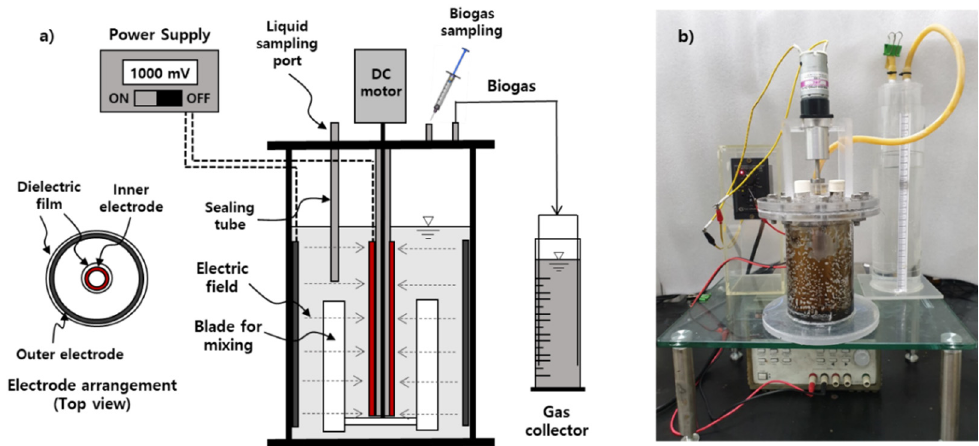
Figure 1. Bioelectrochemical anaerobic batch reactor used in the experiment: ( a ) schematic diagram, ( b ) photograph.